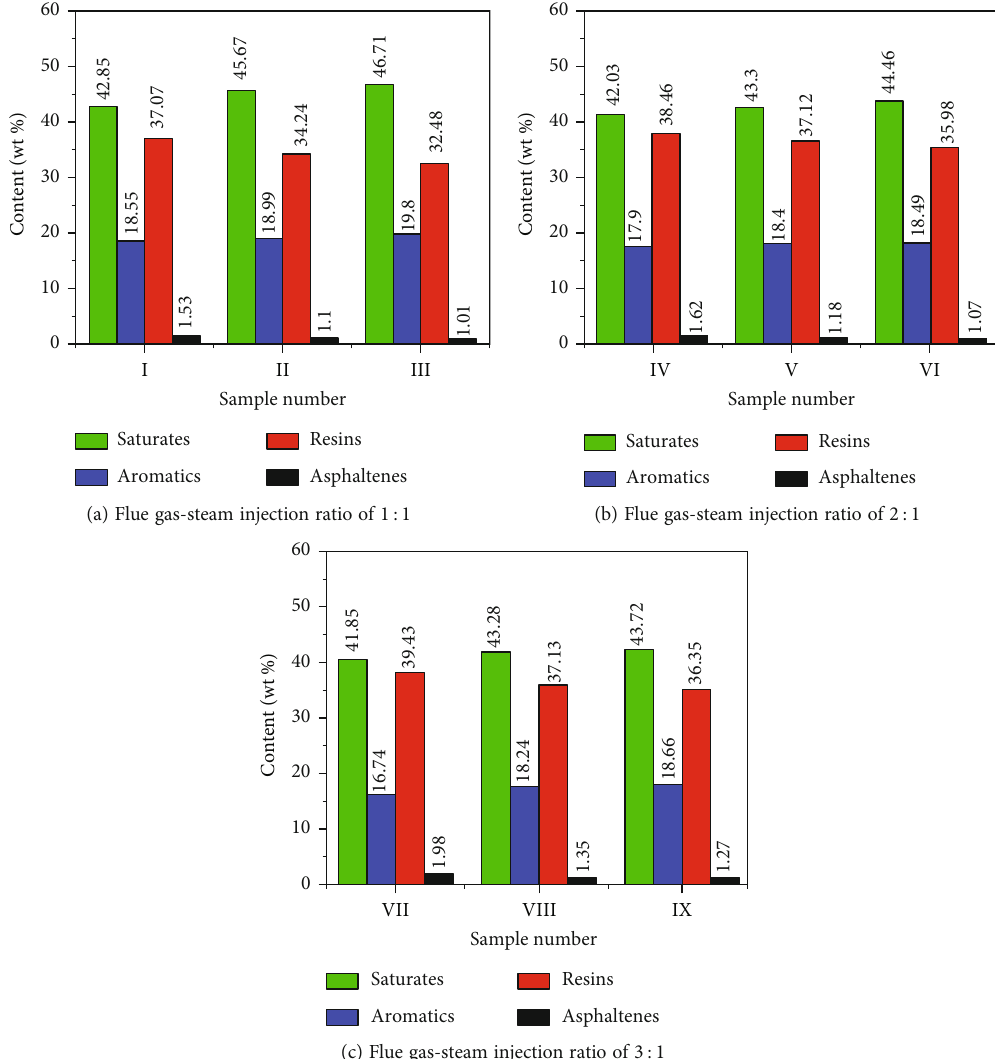
Figure 11: Comparison of the four-component contents of residual oil under di ff erent injection ratios of fl ue gas and